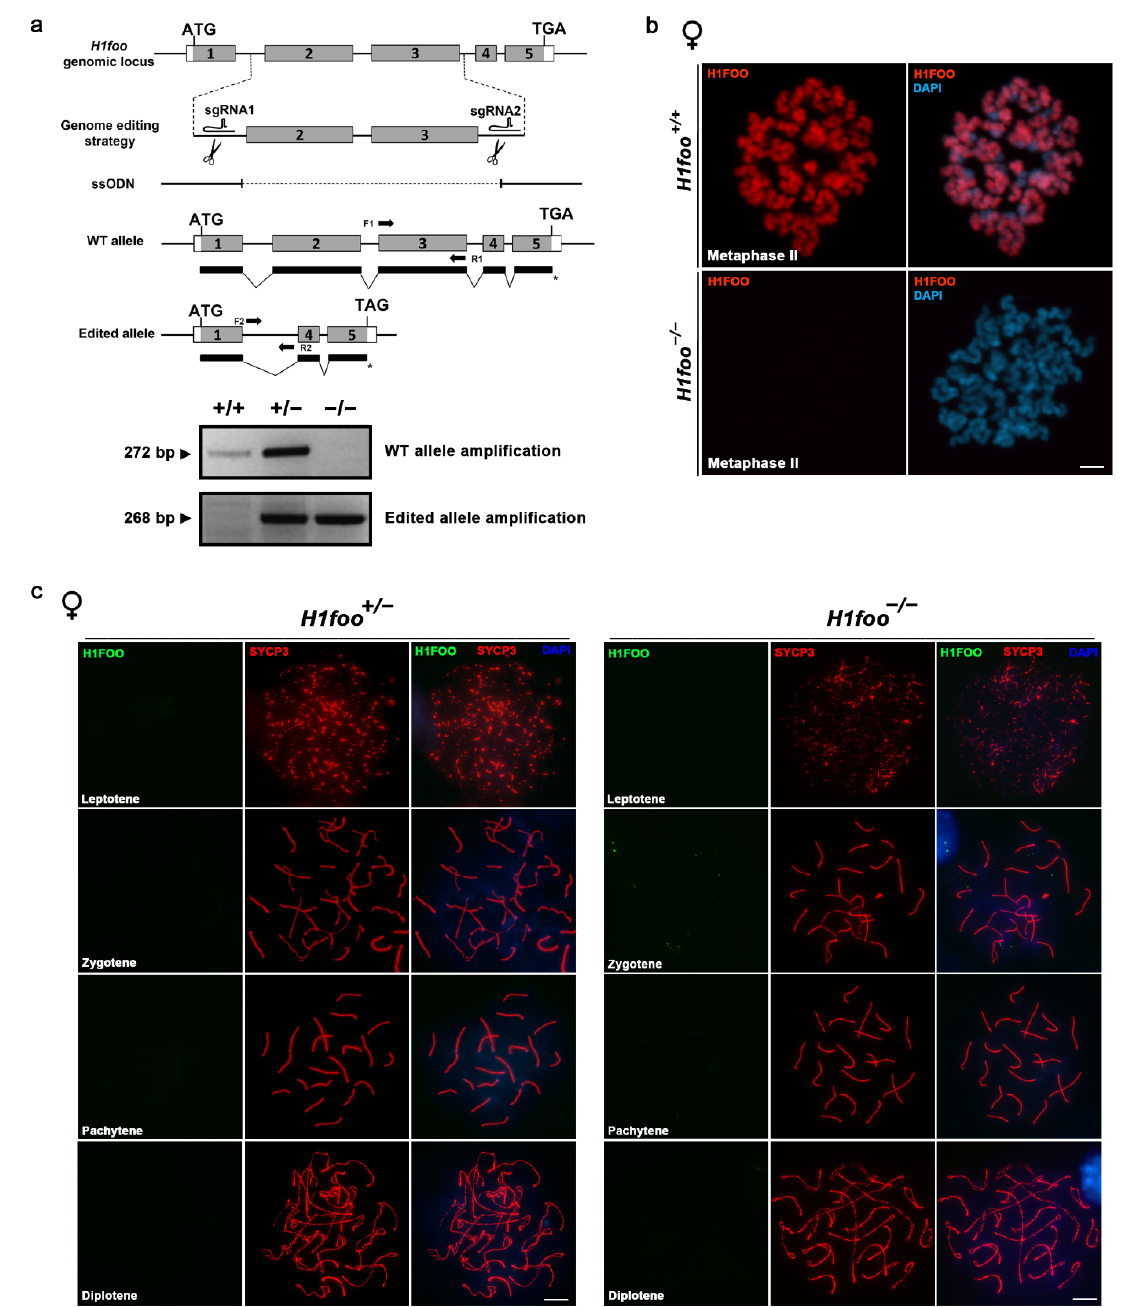
Figure 1. ( a ) Schematic representation of H1foo KO generation by CRISPR–Cas9 genome editing. Two sgRNAs flanking coding exons 2 and 3, respectively, of the H1foo genomic locus are represented. Coding (grey) and non-coding (open box) regions are indicated. Thick lines under the exons represent the expected transcripts derived from WT and H1foo edited alleles, with the * symbol pointing the translation termination. ATG, start codon; TGA, stop codon. Oligonucleotide sequences employed for the amplification of both WT (F1 and R1) and edited alleles (F2 and R2) are also pointed out. PCR analysis of genomic DNA from three H1foo +/+ , H1foo +/ − , and H1foo − / − pups is shown (lower panel). ( b ) H1FOO immunolabeling in cultured unfertilized metaphase II oocytes from both H1foo +/+ and H1foo − / − females showing H1FOO signal (red) decorating the chromosomes of WT, but not mutant oocytes. ( c ) Double immunolabeling of H1FOO (green) and SYCP3 (red) in fetal 16.5 dpc oocytes showing a complete absence of H1FOO signal along meiotic prophase I in both heterozygous and KO oocytes. Bars in panels ( b , c ), 10 µ